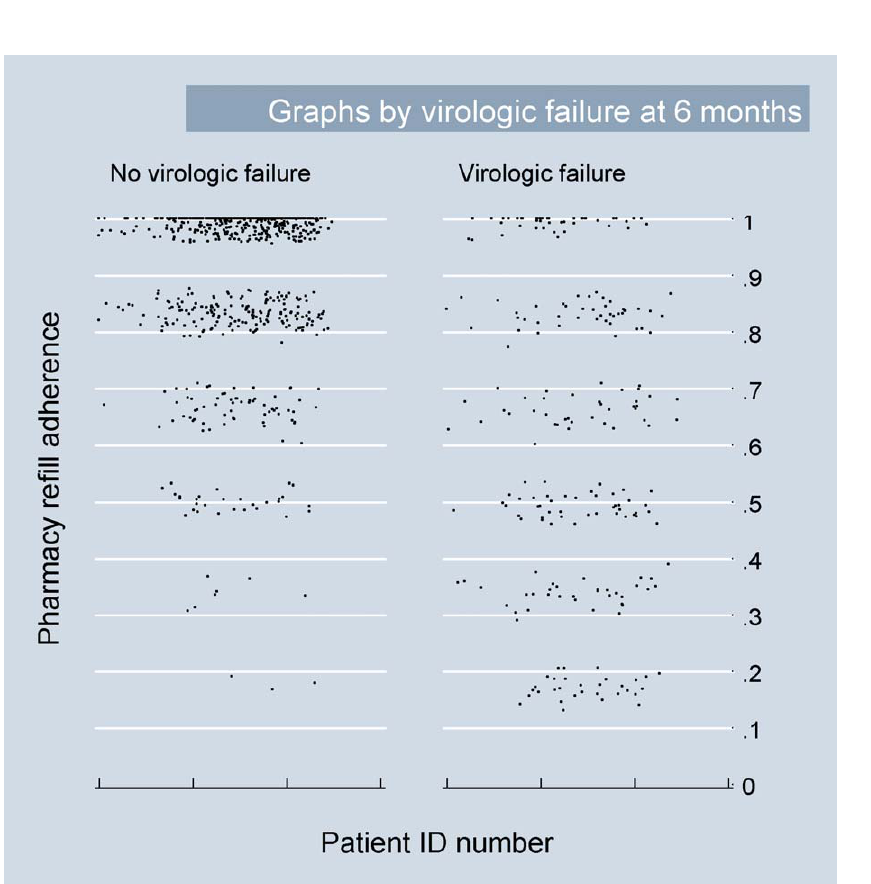
Figure 2. Scatter Plot of Pharmacy Refill Adherence Levels at 6 Months after Starting cART for Patients with and without Virologic